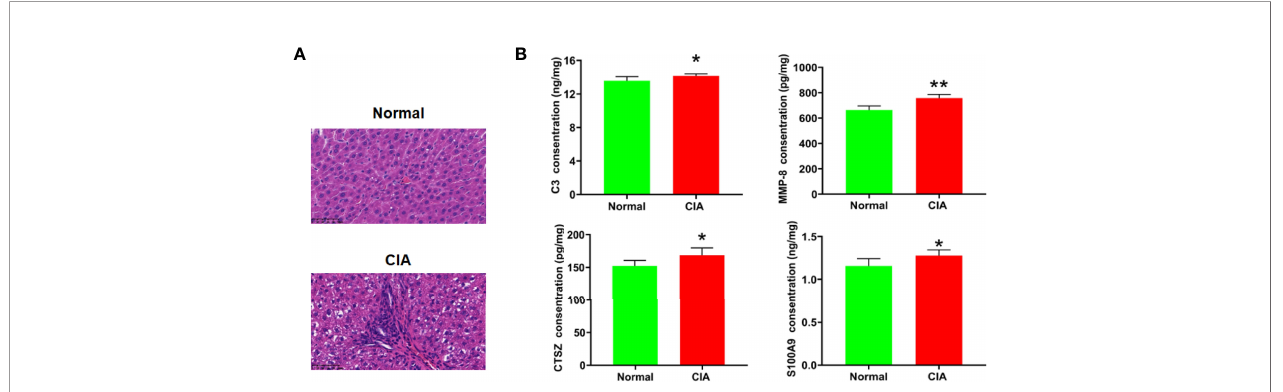
FIGURE 7 | Veri fi cation of the change of immune function in the liver of CIA rats in the peak phase. (A) HE staining of the liver (×400), scale bar = 50 m m. (B) The veri fi cation of key DEPs related to complement activation and migration or adhesion of immune cells. Data were expressed as mean ± SD. N = 6. * p < 0.05, ** p < 0.01 compared with the normal